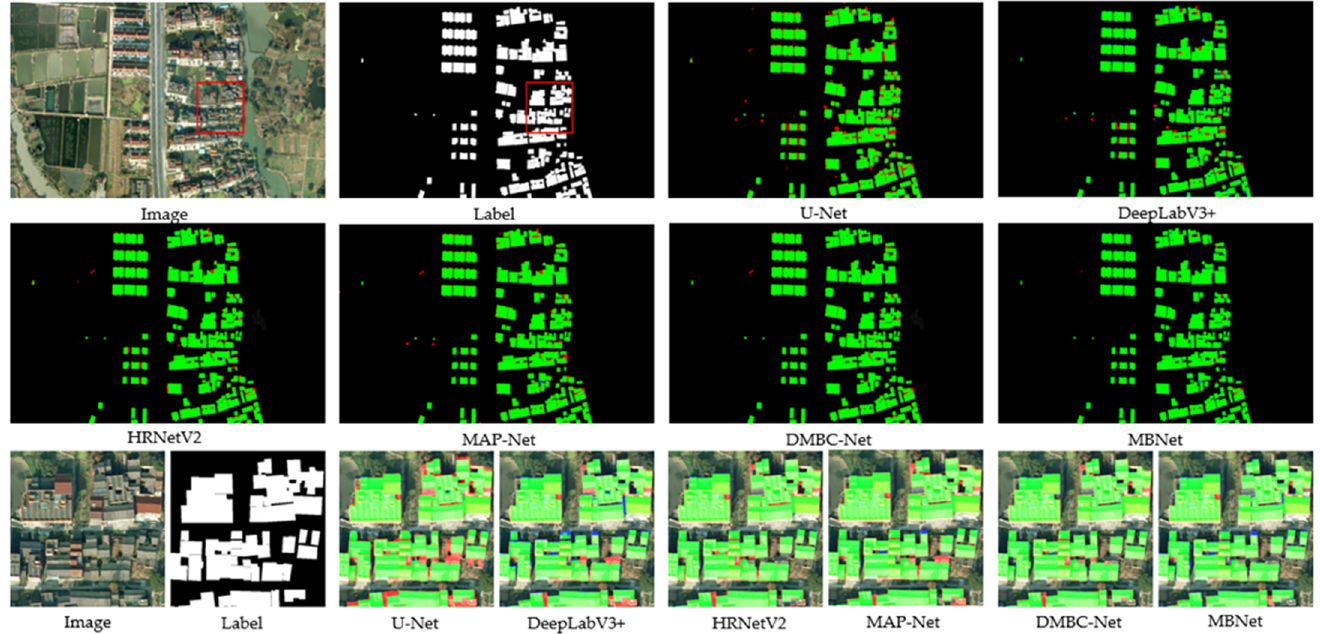
Figure 9. Segmentation results of the different SOTA methods on the plain landform scene 1 test dataset. The bottom row is a close-up view of the red box.